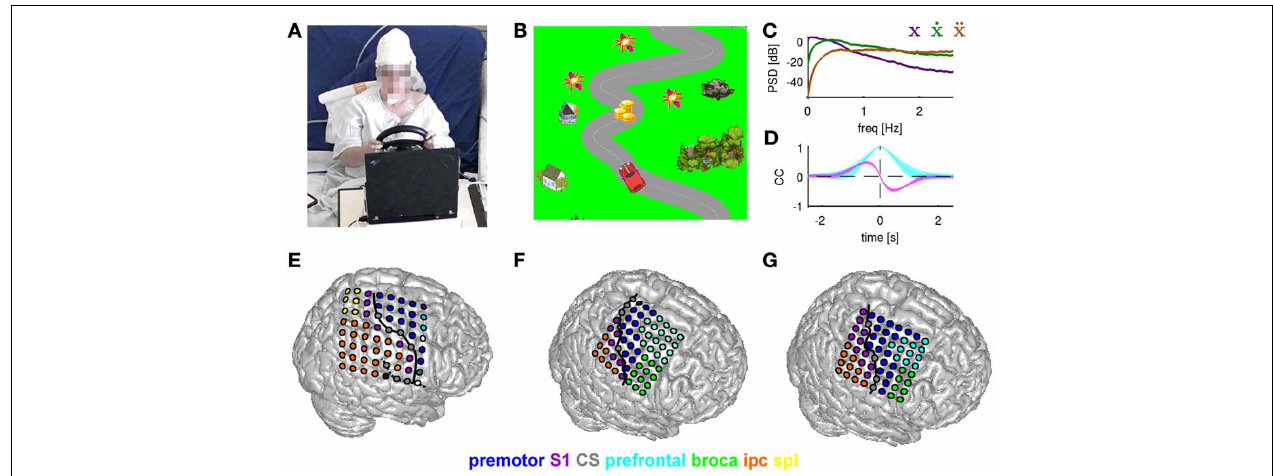
FIGURE 2 | Motor task and ECoG grid implantations. (A) Subject S1 driving the car with a steering wheel. The paradigm (car racing game) was presented to the subjects on a laptop computer placed in front of them. (B) Paradigm example. Snapshot of the car on a road with objects to be collected (coins) and avoided (dynamites). Non-interactive background objects included houses and trees. The subject controlled the car in the horizontal (left/right) dimension. (C) Power spectrum density (PSD) for movement position